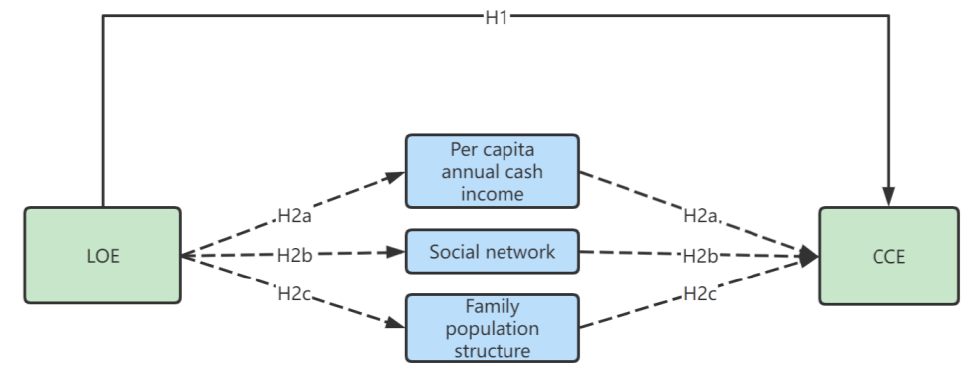
Figure 1. Mechanism map of LOE and CCE use.